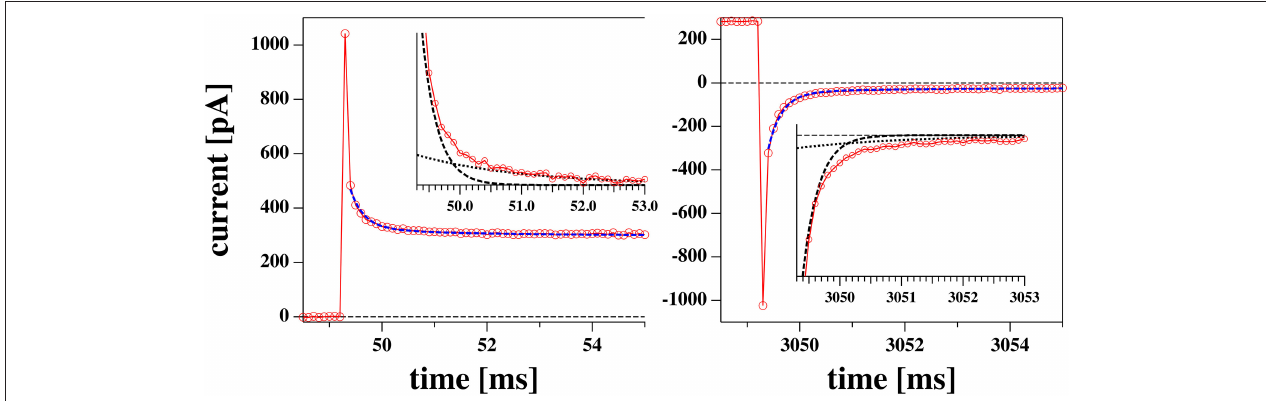
FIGURE 4 | Initial phase of a voltage jump from 0 to 0.175 V (left) and back (right) from the experiment shown in Figures 5B,D . The profiles are reasonably well-fitted by a biexponential function with the same two relaxation times for the jump in both directions. The two exponential functions are shown in the inserts.